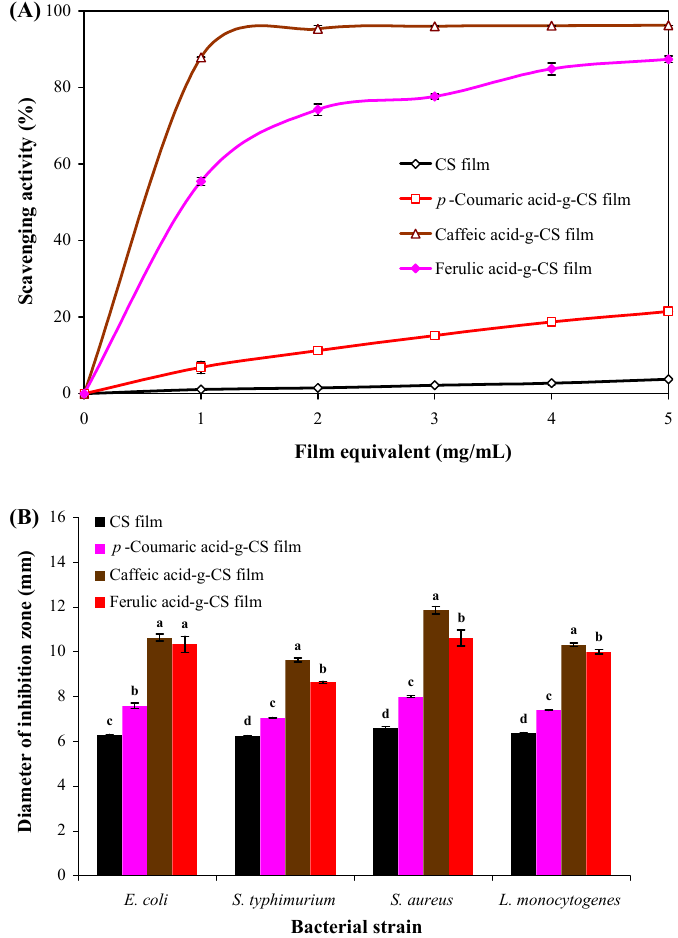
Figure 6. DPPH radical scavenging activity ( A ) and antimicrobial activity ( B ) of chitosan (CS) and different hydroxycinnamic acid-g-CS films. Data are presented as the mean ± SD of triplicates. Different lowercase letters indicate a statistically significant difference among treatments against the same bacterial strain ( p < 0.05).